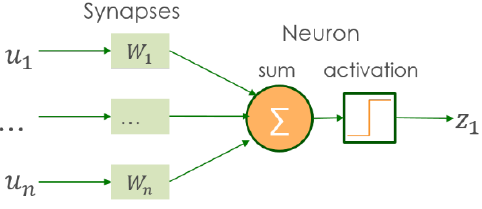
Figure 5. Fundamental components of artificial neural network.